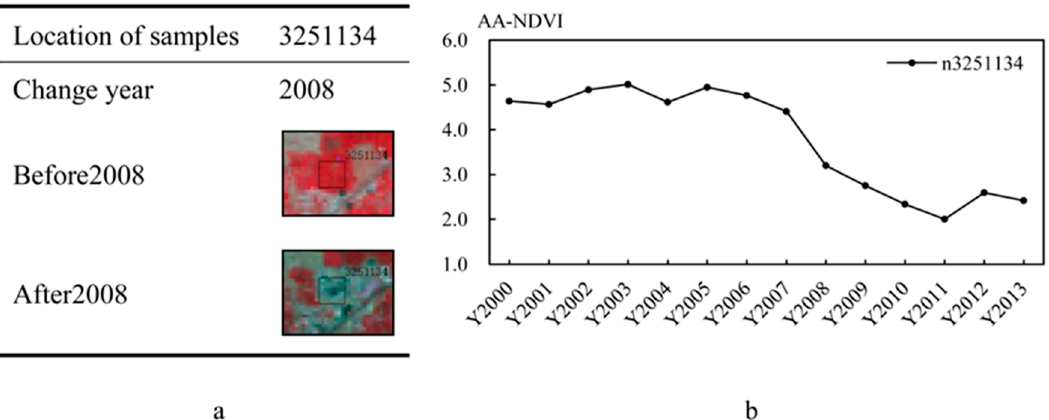
Figure 4. Visual interpretation processes for validation of abrupt land cover change: ( a ) visual interpretation of remote sensing images; and ( b ) profiles of time series AA-NDVIs trajectories for the corresponding pixel in the black rectangle shown in ( a ).